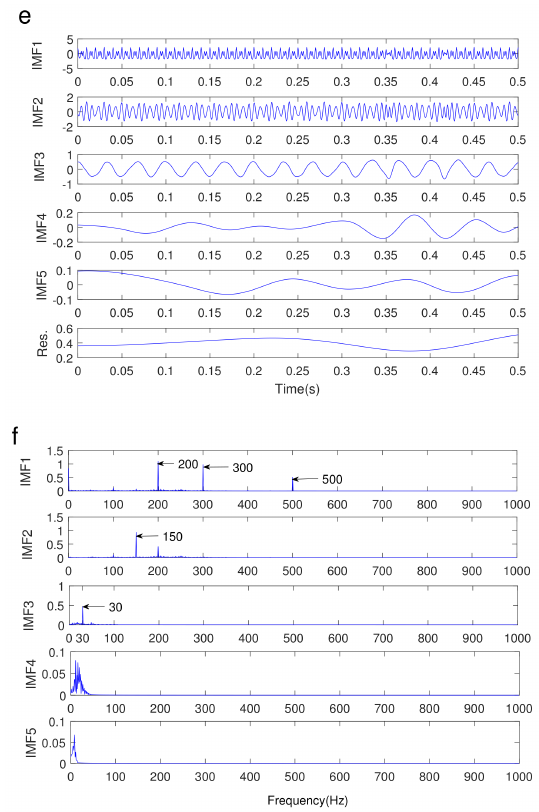
Figure 3. Multi-harmonic signal analysis: ( a ) results of VMD with the initialization of the center frequency P u and their spectra ( b ); ( c ) results of VMD with the initialization of the center frequency P z and their spectra ( d ); ( e ) results of empirical mode decomposition (EMD) and their spectra ( f ). IMF = intrinsic mode function; BLIMF = band-limited intrinsic mode